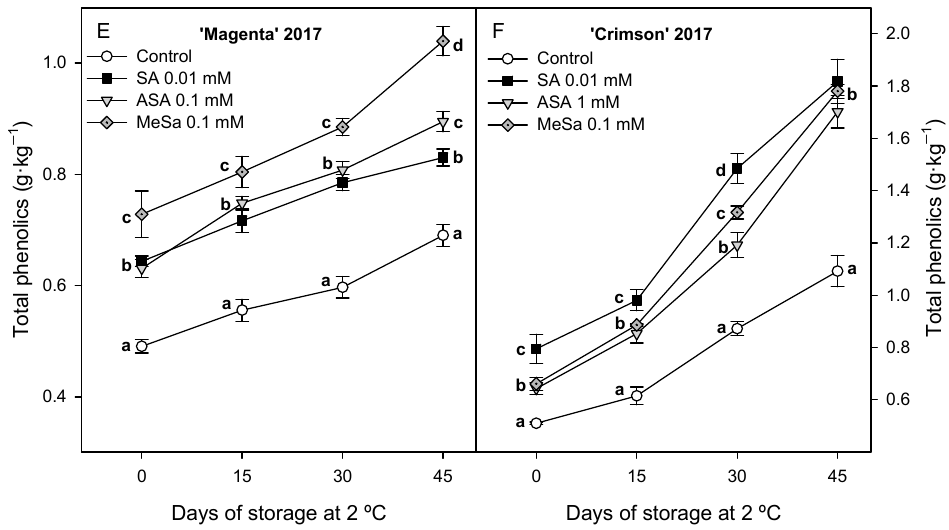
Figure 5. Total phenolic concentration at harvest and during storage at 2 °C in 2017 experiment in control and salicylic acid (SA), acetyl salicylic acid (ASA) and methyl salicylate (MeSa) treated berries of ‘Magenta’ ( A ) and ‘Crimson’ ( B ) cultivars. Data are the mean ± SE of quantifications made in duplicate in three replicates. Different letters show significant differences ( p < 0.05) among treatments for each sampling date.